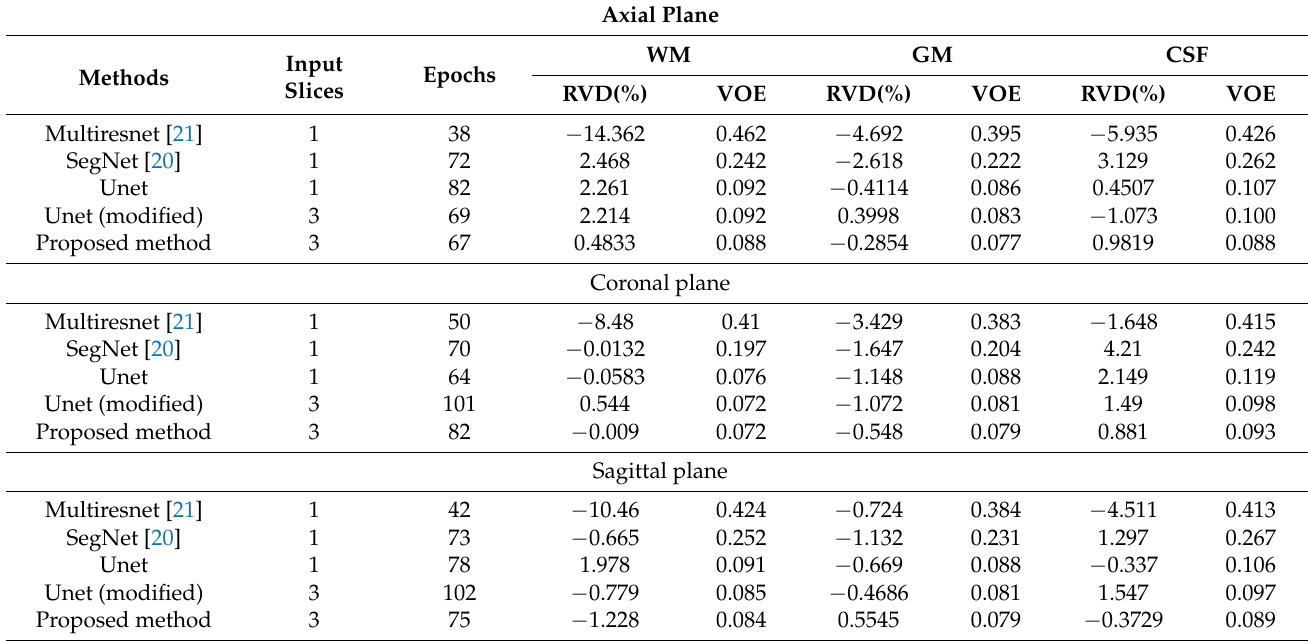
Table 4. RVD and VOE comparison between the Multiresnet, SegNet, single-slice input UNet, multi-slice UNet, and the proposed SIP-UNet. Axial